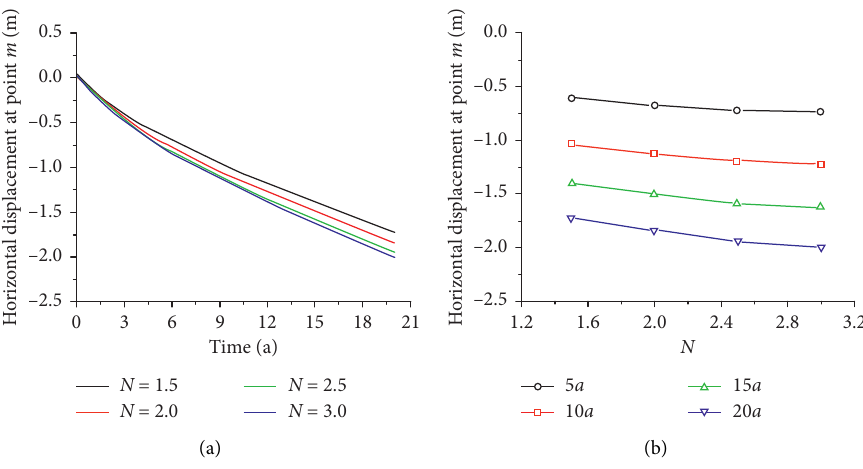
Figure 8: Variation rule of horizontal displacement at point m with operation time and diameter-to-height ratio. (a) The horizontal displacement of point m changing with operation time. (b) The horizontal displacement of point m changing with of diameter-to-height ratio.